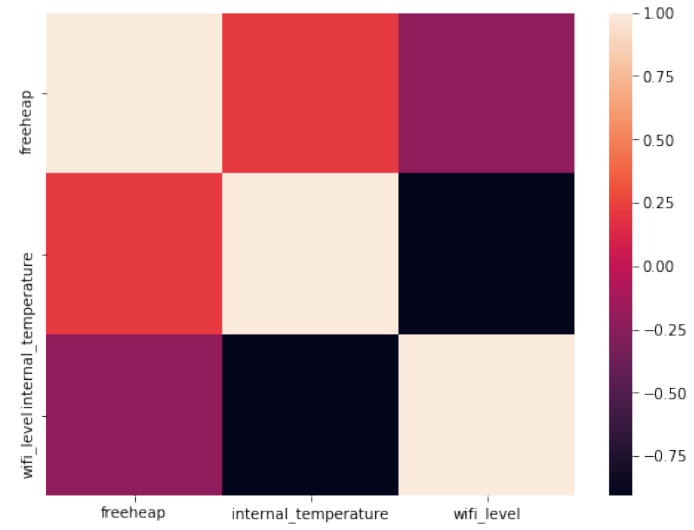
Figure 10. Remote lab metrics correlation matrix.